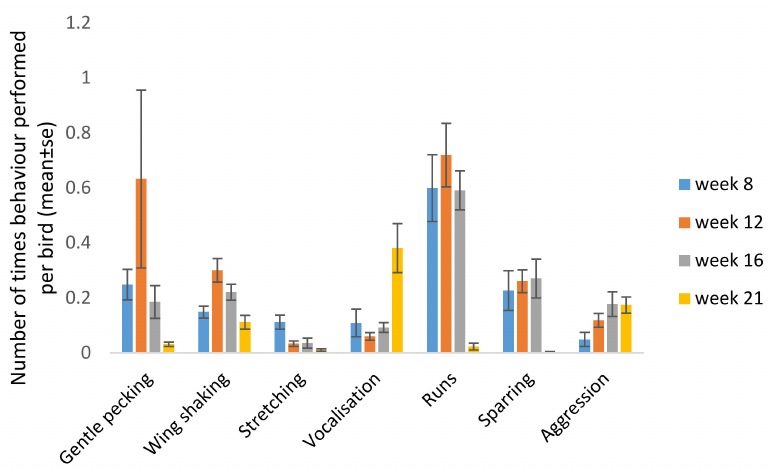
Figure 2. Number of times different behaviours were observed per bird in the home pen at 8, 12, 16 and 21 weeks of age (mean of all light